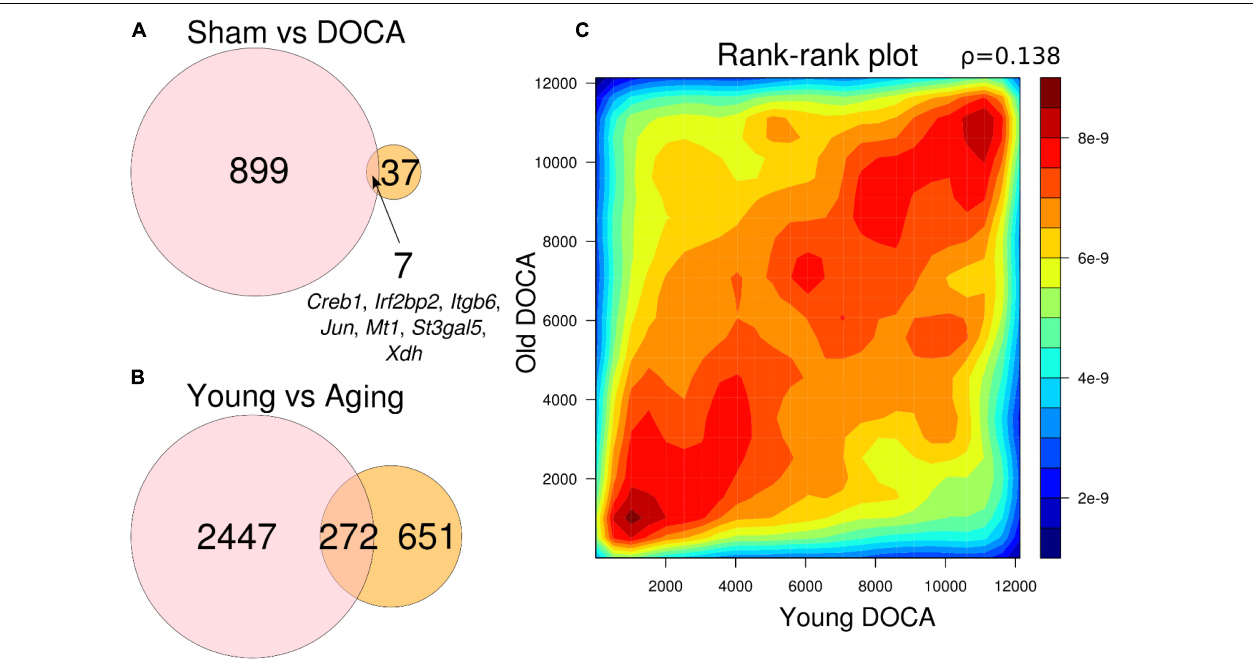
FIGURE 5 | Venn diagrams showing number of genes differentially expressed between (A) sham vs. DOCA mice according to age group (young vs. aging) and genes in common between the two groups; and (B) young and aging mice according to cardiovascular health (sham vs. DOCA). All genes in (A) and (B) are FDR < 0.05. (C) Rank–rank plot of all detected genes between young and aging DOCA mice showing they have similar patterns of gene expression.